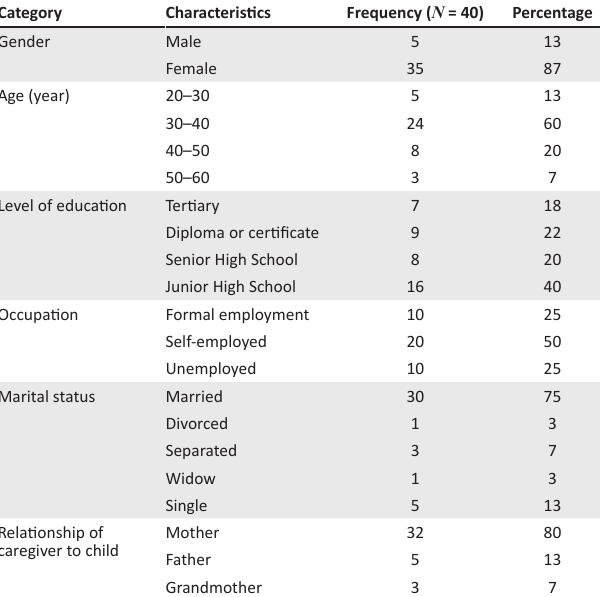
TABLE 1: Distribution of demographic characteristics of